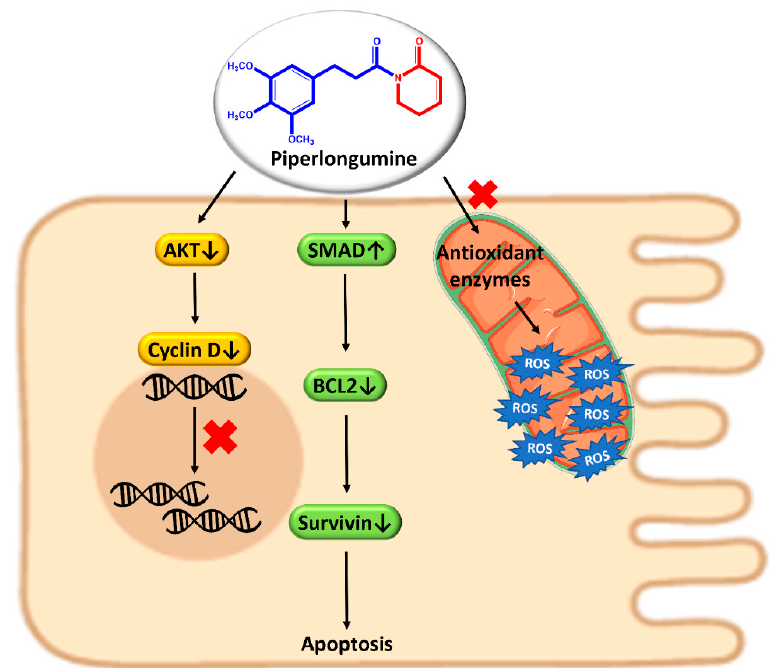
Figure 3. Anticancer mechanism of piperlongumine in colon cancer.